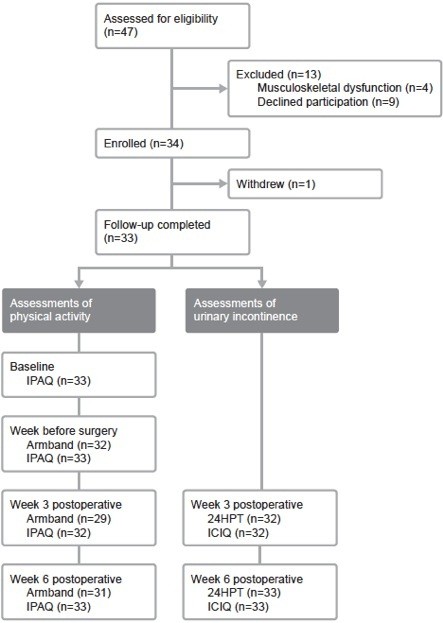
Flowchart of patients through the study period.IPAQ, International Physical Activity Questionnaire; ICIQ, International Consultation on Incontinence Questionnaire – Urinary Incontinence Short Form; 24HPT, 24-hour pad test.